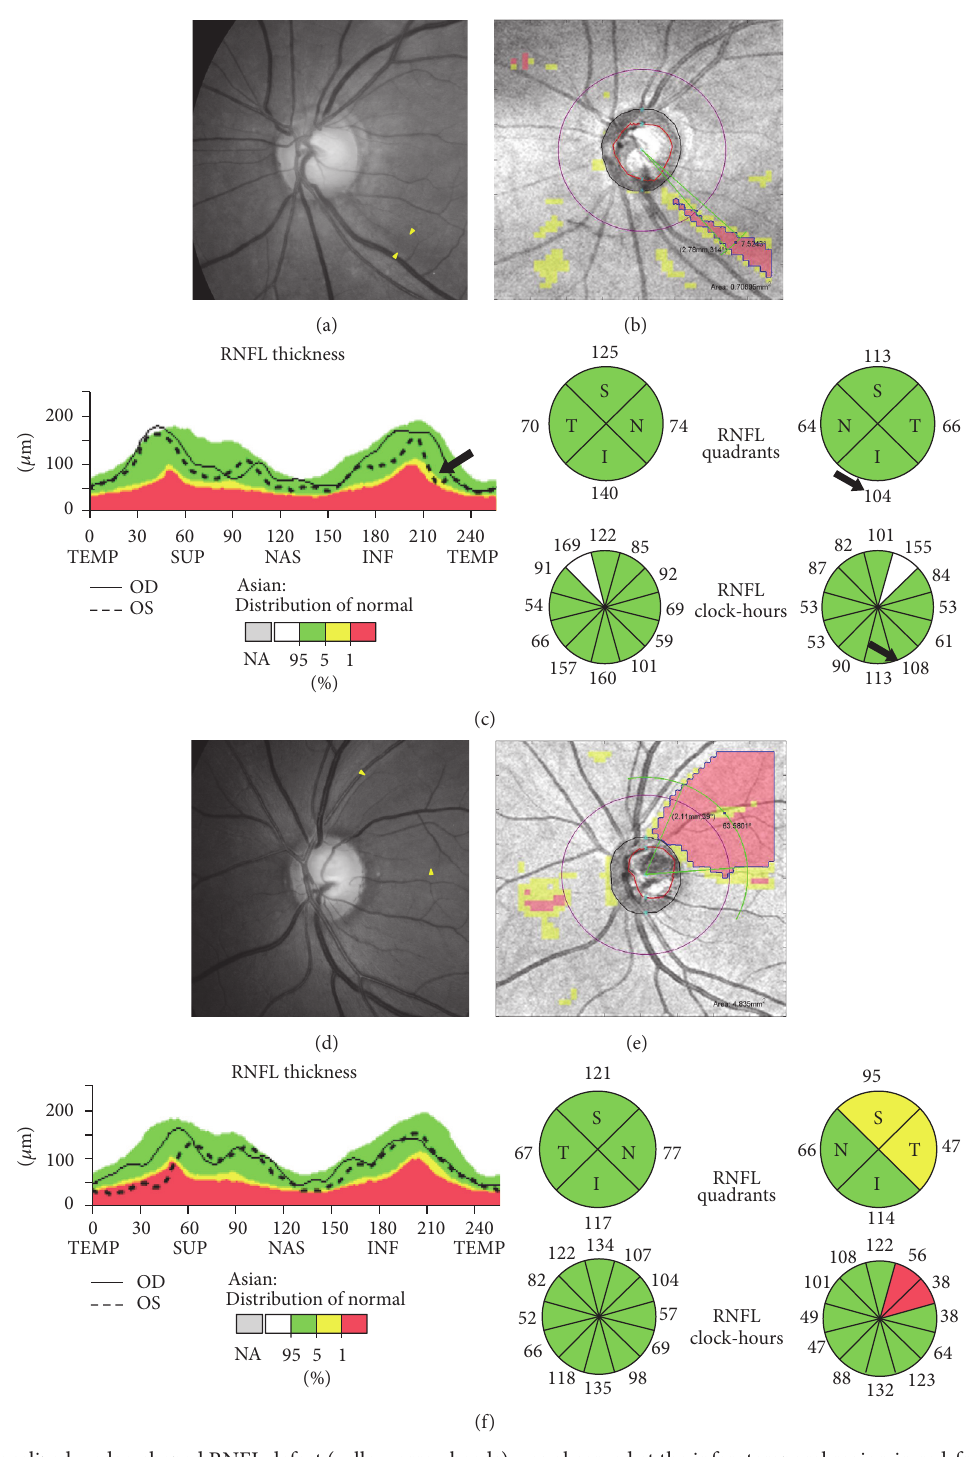
Figure 1: (a) Localized wedge-shaped RNFL defect (yellow arrowheads) was observed at the inferotemporal region in red-free photography. (b) RNFL defect (blue line) was defined as at least 10 contiguous red ( < 1% level) superpixels in the RNFL deviation map. The center (black dot) of the RNFL defect was calculated with polar coordinates [ 𝑟 = 2.78 mm, 𝜃 = 314 ∘ ] ( 𝑟 : distance from the center of the optic disc, 𝜃 : angle from a temporal equator in a clockwise direction in right eyes and in a counterclockwise direction in left eyes). The angular width of the RNFL defect was determined as 7.52 ∘ where the boundary (blue line) of the RNFL defect met the circle (green arc) passing through the center of the RNFL defect. This was classified as a localized RNFL defect because of the angular width < 30 ∘ . (c) In circumpapillary RNFL measurements, quadrant and clock-hour maps could not detect abnormalities at the corresponding area, although the TSNIT graph yielded suspicious downslope (black allows). (d) Diffuse RNFL defect (yellow arrowheads) was observed at the superotemporal region in red-free photography. The lower border was quite unclear for determination of the boundary. (e) The lesion was located at [2.11mm, 39 ∘ ] and corresponded to diffuse RNFL defect with angular width of 63.58 ∘ . (f) For a diffuse RNFL defect, circumpapillary RNFL measurements detected abnormalities at the corresponding area relatively